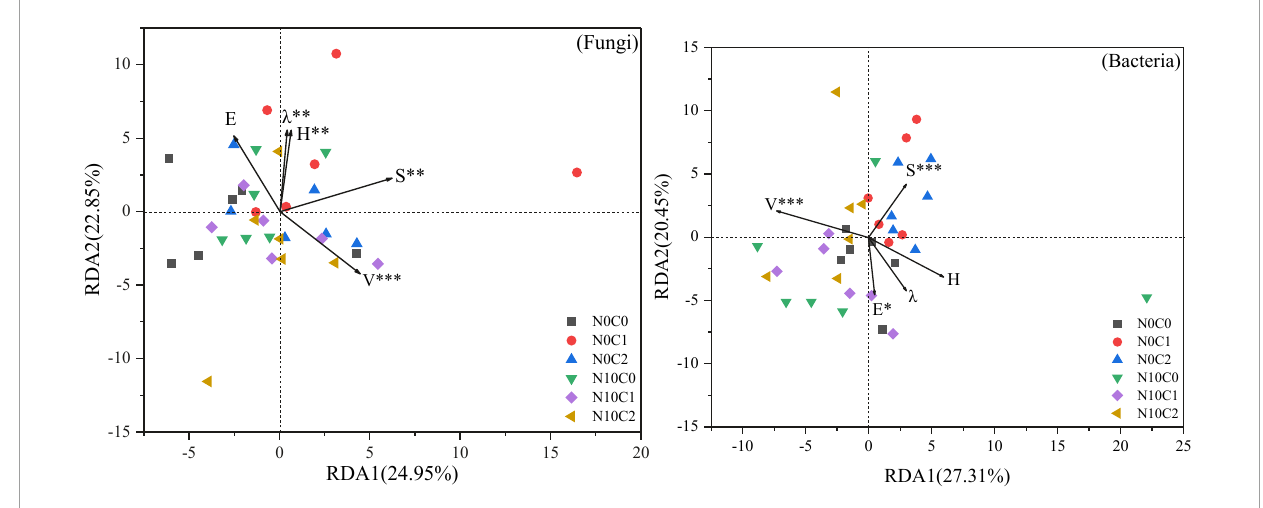
FIGURE6 Redundancy analysis (RDA) of plant community diversity and soil microbial species distribution in community under N addition and litter manipulation. Significance levels of each plant community factor were calculated by Envifit function ( ns p > 0.1; # p < 0.1; * p < 0.05; ** p < 0.01; *** p < 0.001).